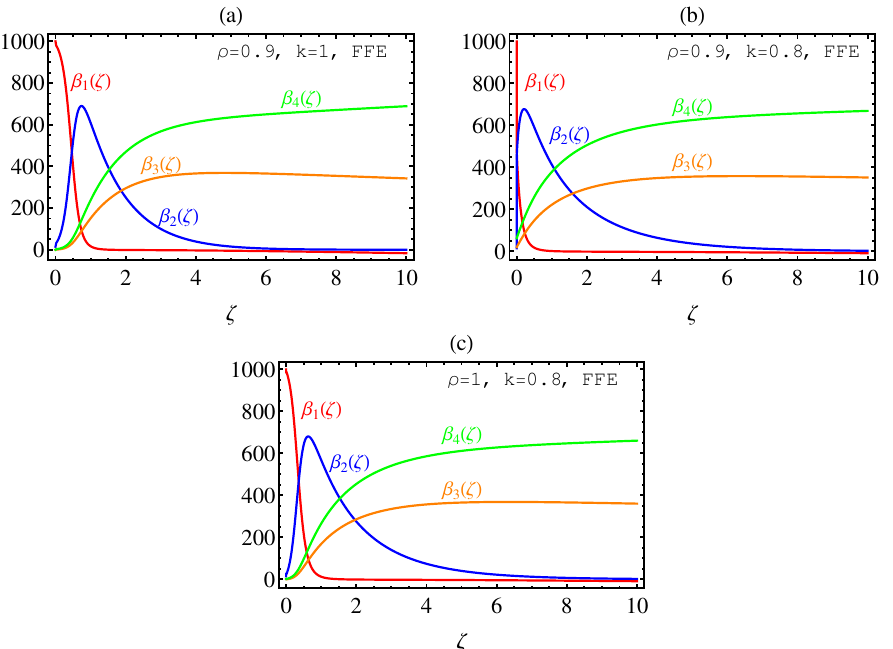
Figure 3. Graph of the numerical solutions based on FFE for ( a ) ρ = 0.9, k = 1, ( b ) ρ = 0.9, k = 0.8 and ( c ) ρ = 1, k = 0.8, respectively, with λ = 0.01, s = 0.02, δ = 0.6, α = 0.4, β = 0.01, N = 1000, h = 0.02 and the following initial conditions: β 1 ( 0 ) = 1000, β 2 ( 0 ) = 15, β 3 ( 0 ) = 0and β 4 ( 0 ) =